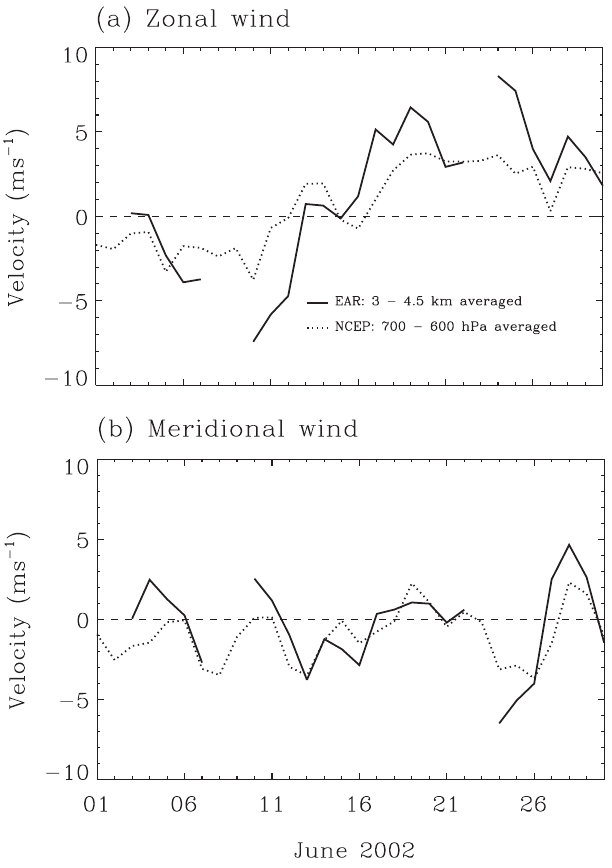
Fig. 6. Time variations of (a) zonal and (b) meridional wind de- rived from EAR and NCEP/NCAR reanalysis. Solid and dotted curves show EAR winds averaged in 3–4.5km and NCEP winds av- eraged in 700–600hPa closest to the observation site (0 ◦ N, 100 ◦ E),